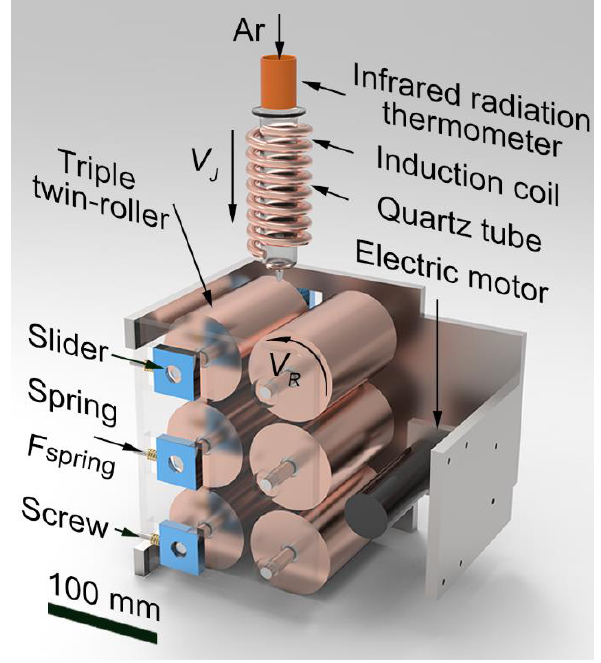
Figure 1. The 3D model of the triple twin-roller casting device.